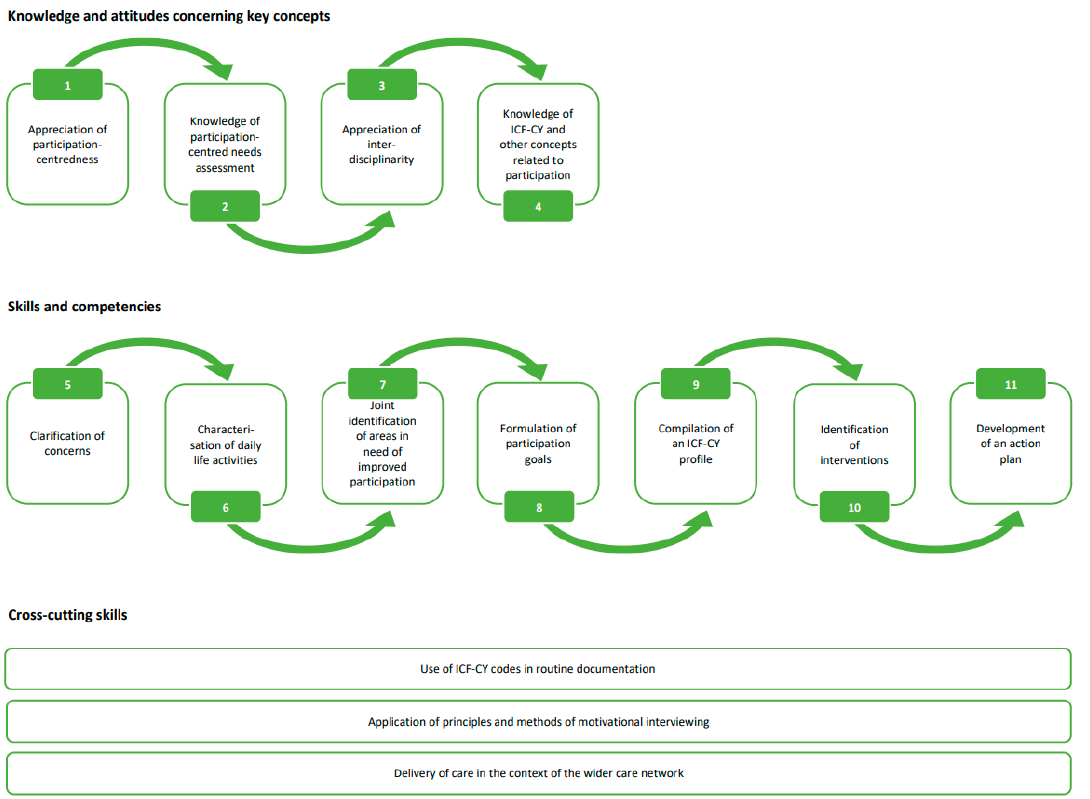
Figure 1. Framework for participation-centred care. ICF-CY, International Classification of Functioning Disability and Health–Child and Youth Version.